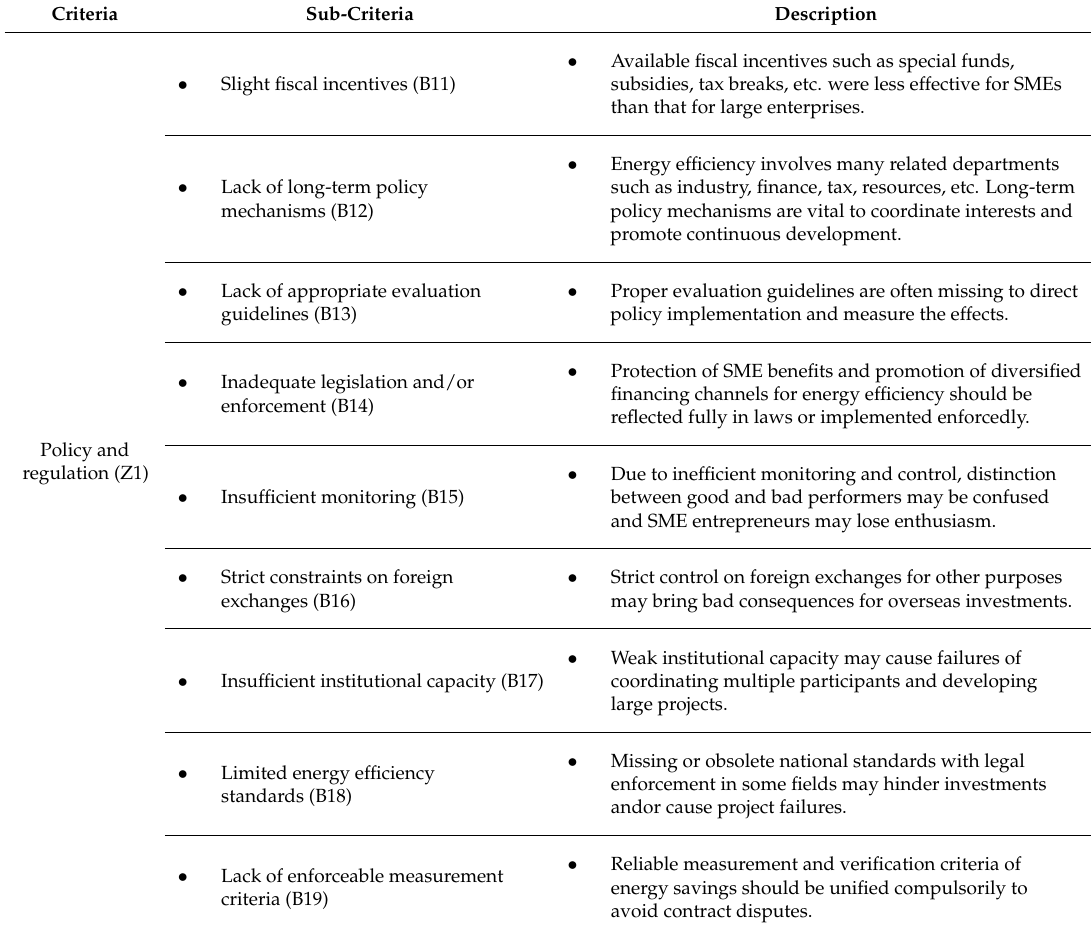
Table 4. Potential barrier factors of energy efficiency financing for